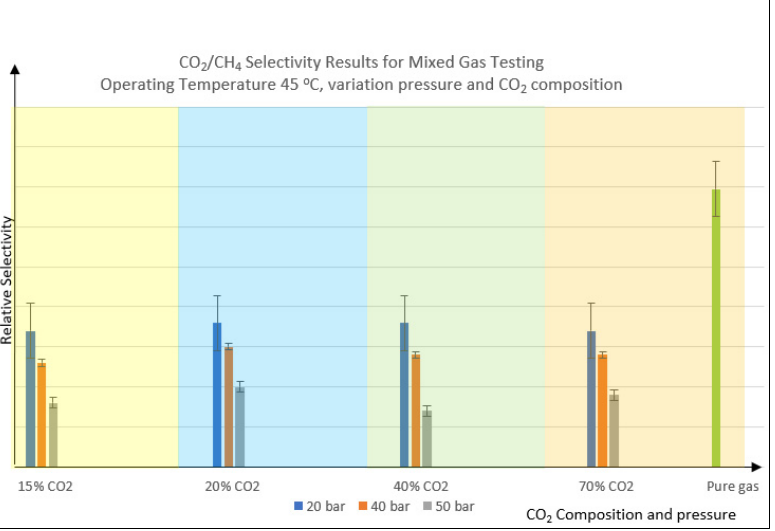
Figure 4. CO 2 /CH 4 selectivity result for mixed gas testing vs. variation of CO 2 composition and feed pressure. Note: Pure gas testing condition is 25 °C temperature with 3 to 7 bar applied